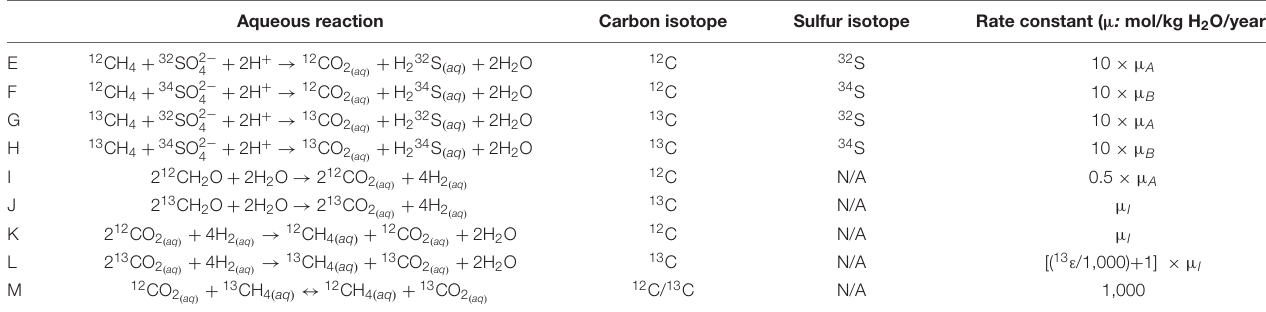
TABLE 3 | The isotopologue-specific aqueous reactions required to track the carbon and sulfur isotopic composition of DIC and sulfate (respectively) during AOM and methanogenesis. Aqueous reaction Carbon isotope Sulfur isotope Rate constant ( µ : mol/kg H 2